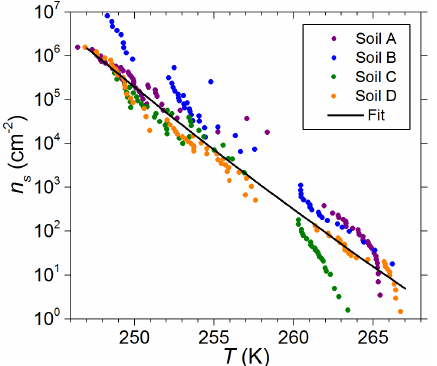
Fig. 8. Fit to ice active site densities for untreated soil dusts as esti- mated from the micro- and nano- drop freezing experiments. The fit equation used is ln n s =2.974 × 10 − 3 × T 2 − 2.160 × T + 366.3, valid from 246 − 267K and yielding an R 2 value of